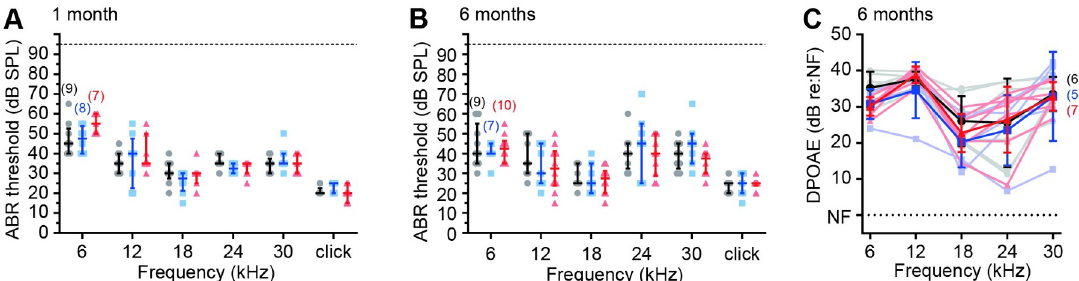
Fig 9. Np65-null mice maintain normal hearing up to 6-months of age. The Nptn Δ exon2 allele was crossed onto the Cdh23 -repaired C57BL/6N background to circumvent interference from the strain-specific Cdh23 age-related hearing loss ( Cdh23 ahl ) allele, and ABR thresholds were tested longitudinally at (A) 1-month and (B) 6-months of age. At each timepoint, the three genotype groups had similar thresholds and were within the expected normal range for the frequencies tested. Data are median ± IQR with individual data points shown. The number of individual mice in each genotype group are shown in brackets. One-way ANOVA comparing against wild type with Dunnett’s correction for multiple comparisons. (C) DPOAE responses of Np65-null ( Nptn Δ exon2/ Δ exon2 ) mice at 6-months of age are comparable to age-matched wild type littermates. Data are mean ± SD. One-way ANOVA comparing against wild type littermate controls using Dunnett’s test for multiple comparisons.